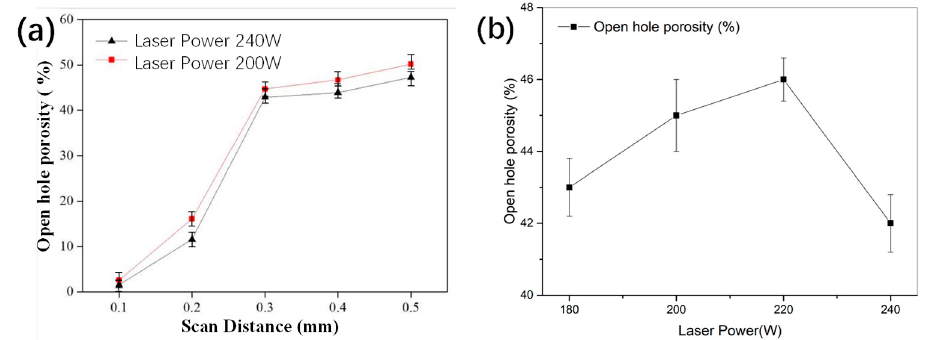
Figure 8. Comparison of the open porosities of the grid structures. ( a ) Open porosities of the grid structures formed by different scan spacings. ( b ) Open porosities of grid structures formed using different laser powers.